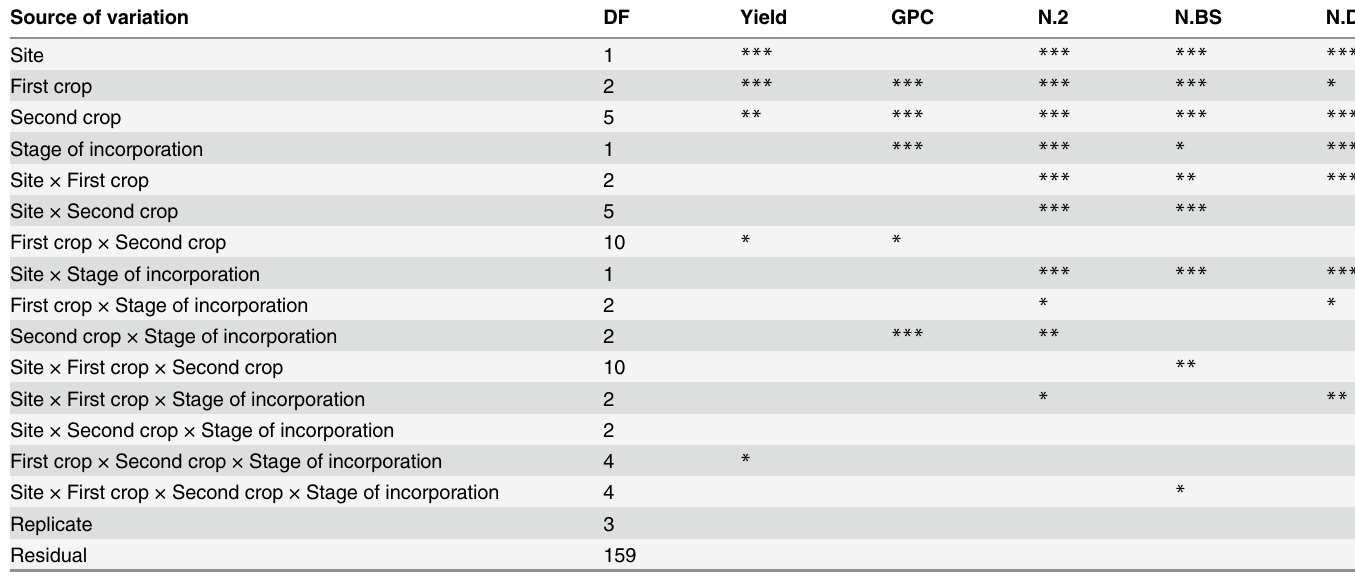
Table 2. Significance levels of terms included in the final models used in the analysis of variance of yield and grain protein concentration (GPC) of barley along with soil mineral nitrogen concentrations two months after incorporation of second crops (N.2), before sowing the final barley crop (N.BS), and difference between incorporation and sowing